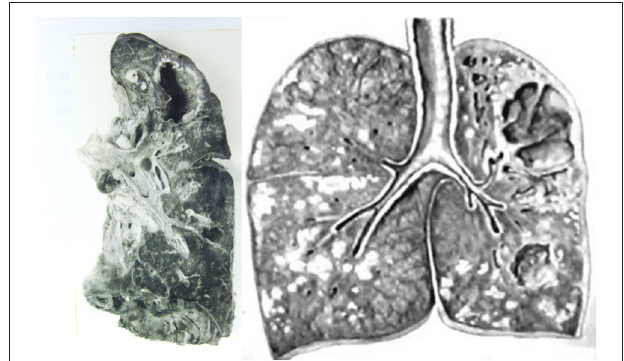
FIGURE 3 | Gross images of pulmonary TB. (Left) Lung with cavity but no other active TB. This is the type of lesion is most favorable to the parasite because the person had only minor symptoms of TB and spread infection for years before dying of other causes. The entire host was protected except for the cavity. (Right) Lung of a person who died of post-primary TB. TB has continued to spread beyond the cavity as obstructive lobular pneumonia, caseous necrosis, and chronic fibrocaseous disease. The necrotic lung that was not coughed out was surrounded by granulomas to become the focus of post-primary granulomas. Photos courtesy of Rich (